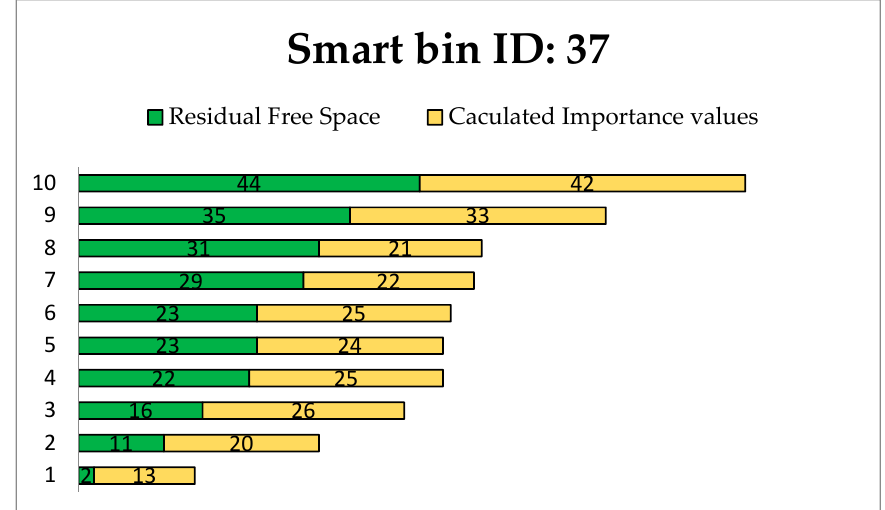
Figure 12. Evaluation routes to smart bin id: 37.